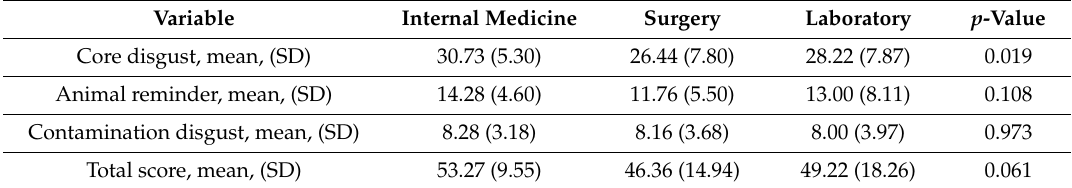
Table 2. Score distribution in relation to specialty orientation of medical students.